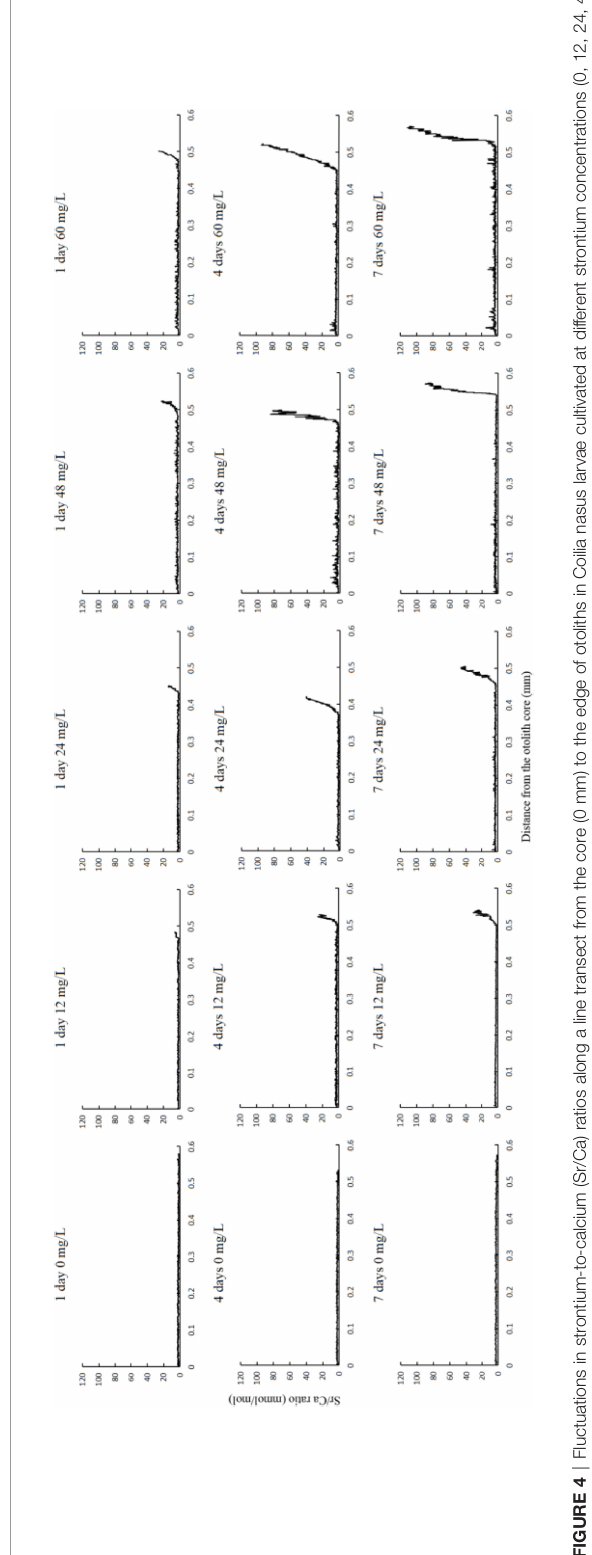
Mean ± standard deviation of 150 samples is shown.